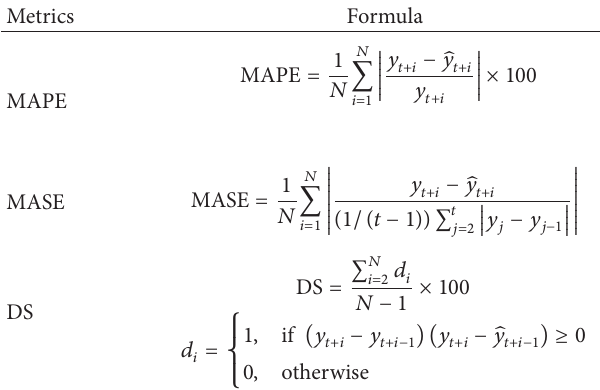
Table 4: MASE of SVR model with different parameter determina- tion